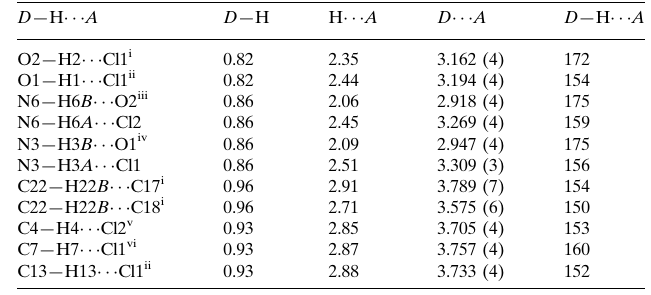
Hydrogen-bond geometry (A˚ , (cid:2)